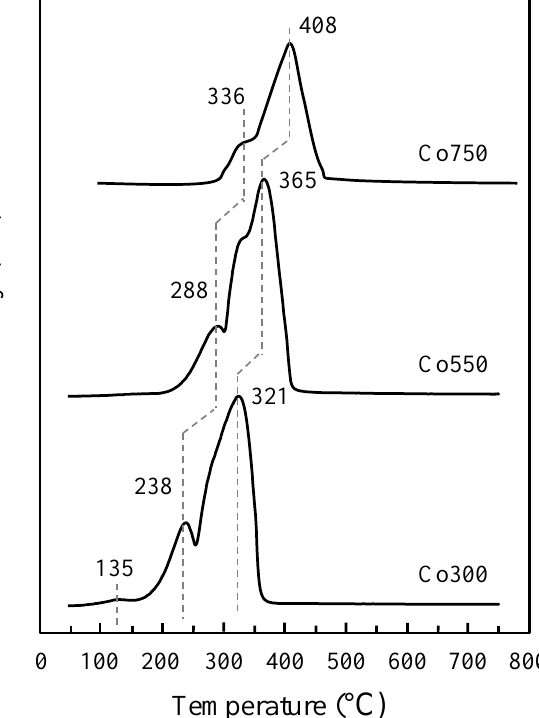
Figure 6. Profiles of temperature-programmed reduction with H 2 (TPR-H 2 ) collected on Co300, Co550, and Co750 catalysts. Conditions: 50 mL min −1 10% H 2 /Ar flow.